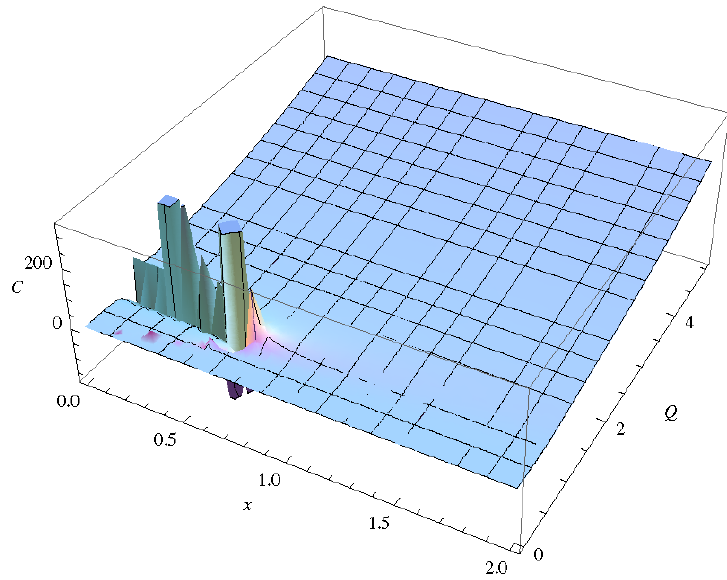
Figure 1. In this figure, we have plotted the variation of specific heat with horizon radius for massive gravity. Here a = b = (cid:96) = 1 and x = r +